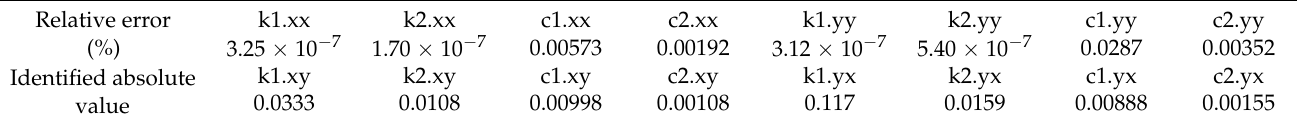
Table 16. The biggest identification error using the computational example